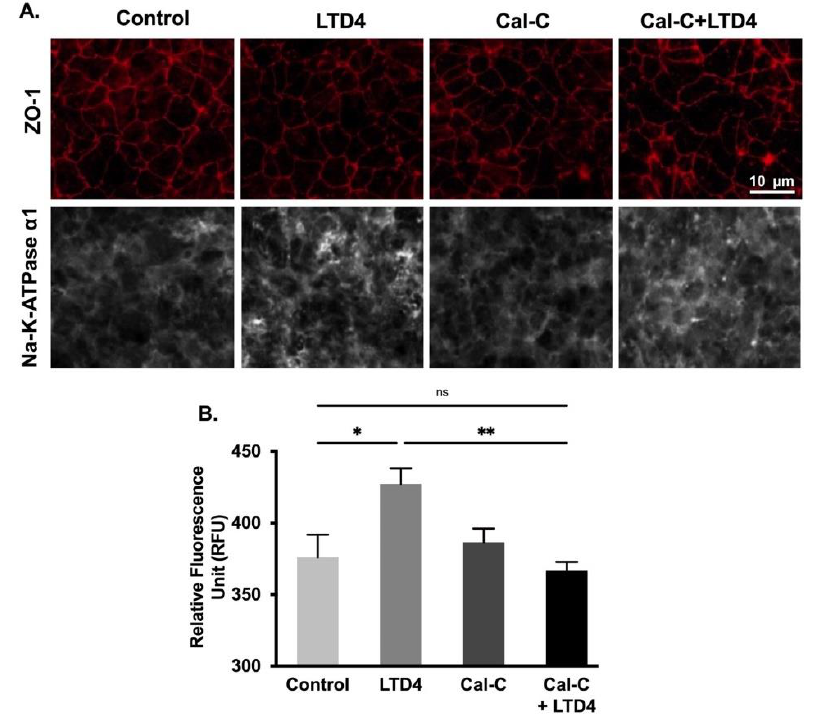
Figure 8. Quantification of Na-K-ATPase α1 through immunocytochemistry when treated with LTD4 and calphostin-C and calphostin-C (PKC inhibitor) for 24 h. ( A ) Representative images of Na-K-ATPase α 1 (gray), and (PKC inhibitor) for 24 h. ( A ) Representative images of Na-K-ATPase α1 (gray), and ZO-1 (Red), (20×). ( B ) Quantification of ZO-1 (Red), (20 × ). ( B ) Quantification of Na-K-ATPase α 1 (green channel). Values are represented as Na-K-ATPase α1 (green channel). Values are represented as mean ± SEM, ( n = 8, Tukey’s multiple comparisons test). *, p < mean ± SEM, ( n = 8, Tukey’s multiple comparisons test). *, p < 0.05, **, p < 0.01; ns., not 0.05, **, p < 0.01; ns., not significant.